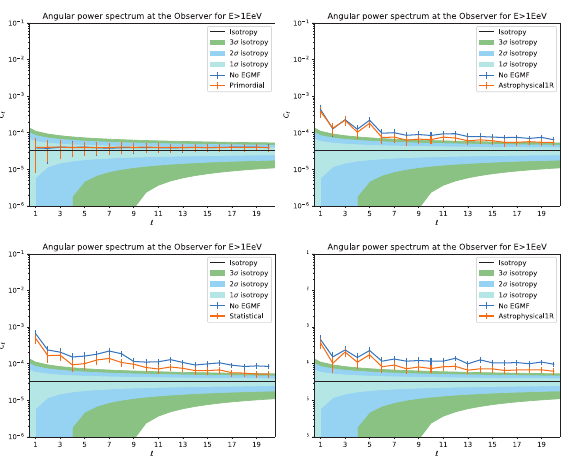
Figure 3. APSs at the observer for 2500 UHECRs with E ≥ 1EeV. Top left: proton injection and homogeneous source distri- bution. Top right: proton injection and mass density source dis- tribution. Bottom left: helium injection and mass halos source distribution. Bottom right: helium injection and mass halos source distribution. In each panel the isotropic prediction given by (2) (black line and coloured areas), the APS without EGMF (blue line) and the APS with one EGMF model (orange line) are shown.